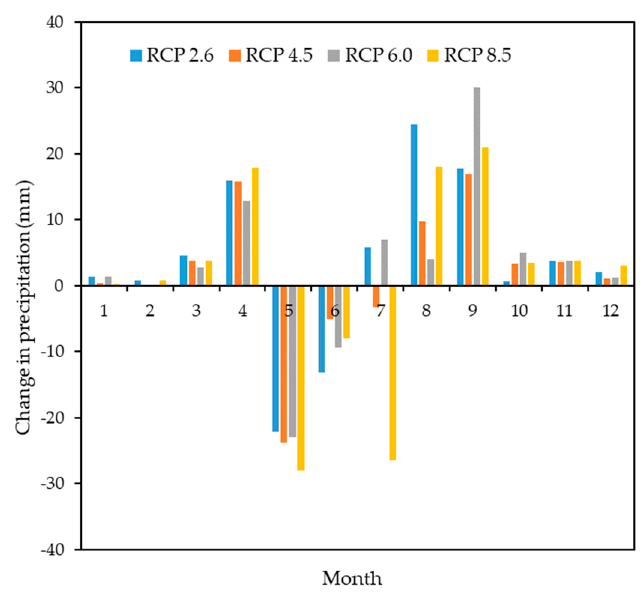
Figure 5. Monthly precipitation changes for the 2050s under RCP 2.6, RCP 4.5, RCP 6.0 and RCP 8.5 emission scenarios compared with the base years (2006–2016).